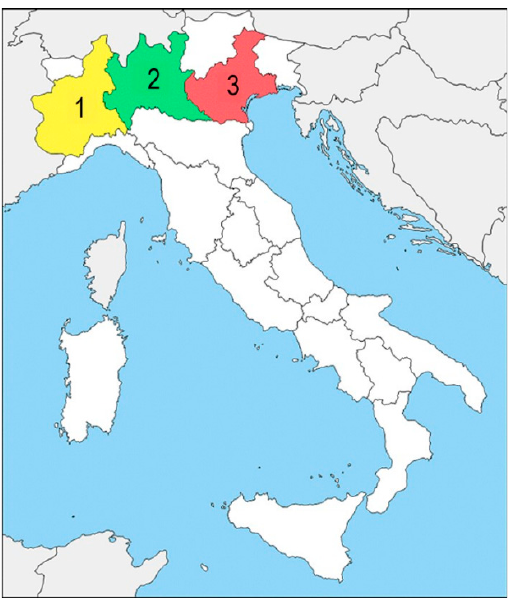
Figure 1. Geographic localization of the zoological facilities from Northern Italy included in this study. 1: Zoological facility from Piedmont; 2: zoological facility from Lombardy; 3: zoological facility from Veneto.